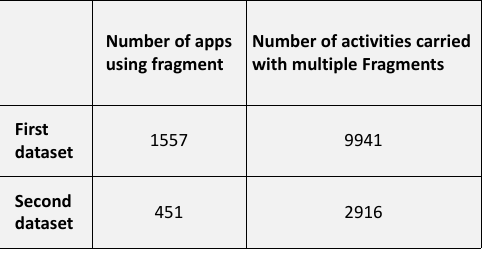
Figure 10. Distribution of the number of Activities carried with multiple Fragments app, 28.3% apps have more than 10 kinds of Fragment classes.